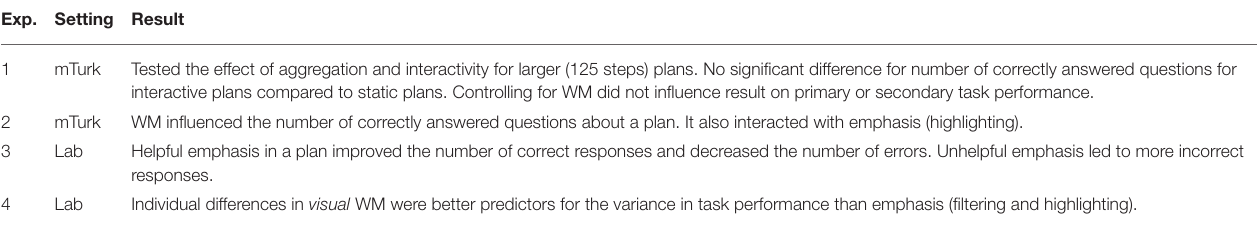
TABLE 9 | Overview of experiments and results. Exp. Setting